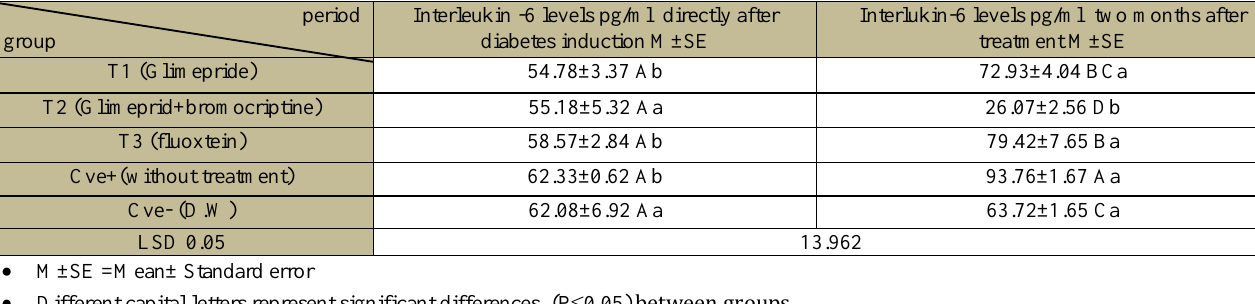
Table, 1: Interleukine-6- level pg/ml in induced diabetic rabbit groups dosed orally for two months with glimepride ,bromocriptine and fluoxtein .